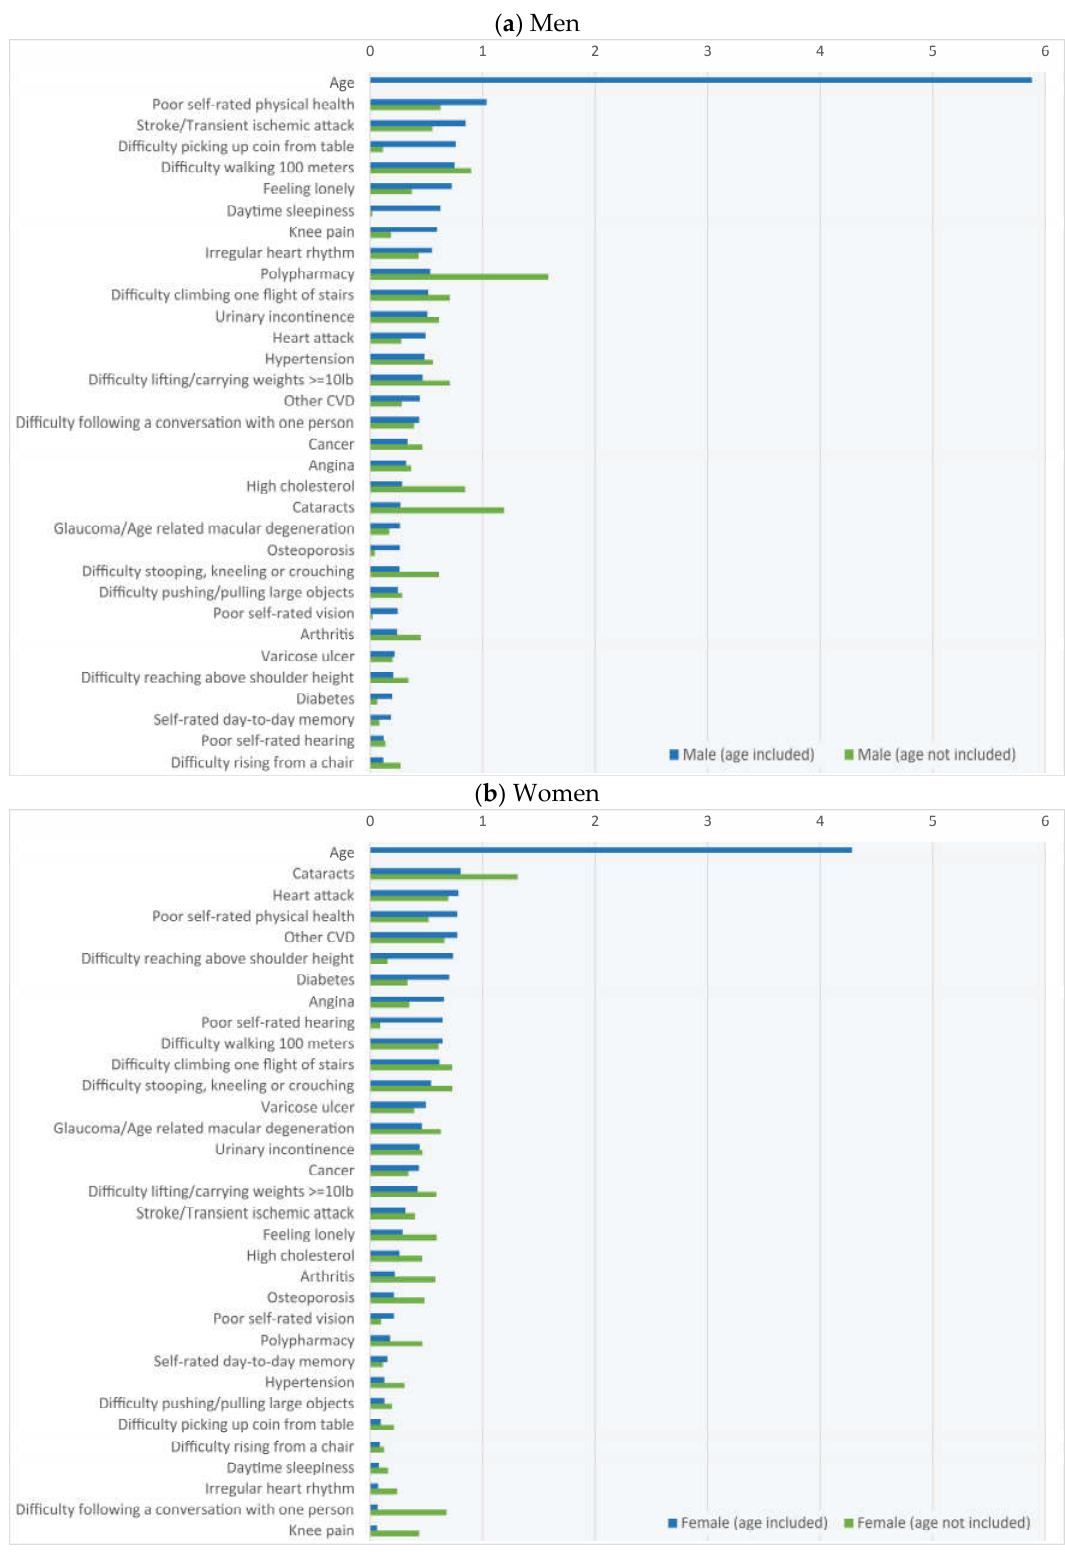
Figure 2. Frailty index feature importance.